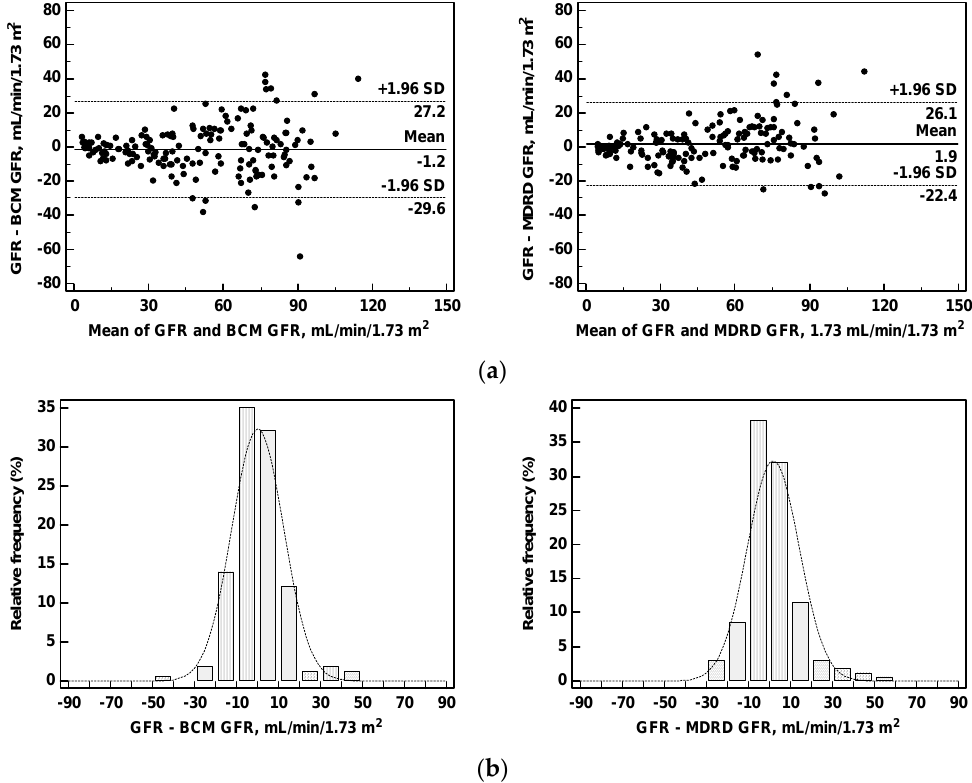
Figure 6. Measured versus predicted glomerular filtration rate (GFR): ( a ) Agreement plots between the measured GFR and the GFR predicted from BCM (BCM GFR) or from the MDRD formula (MDRD GFR), and ( b ) histograms of frequency distribution of the differences between the measured GFR and predicted values of GFR.